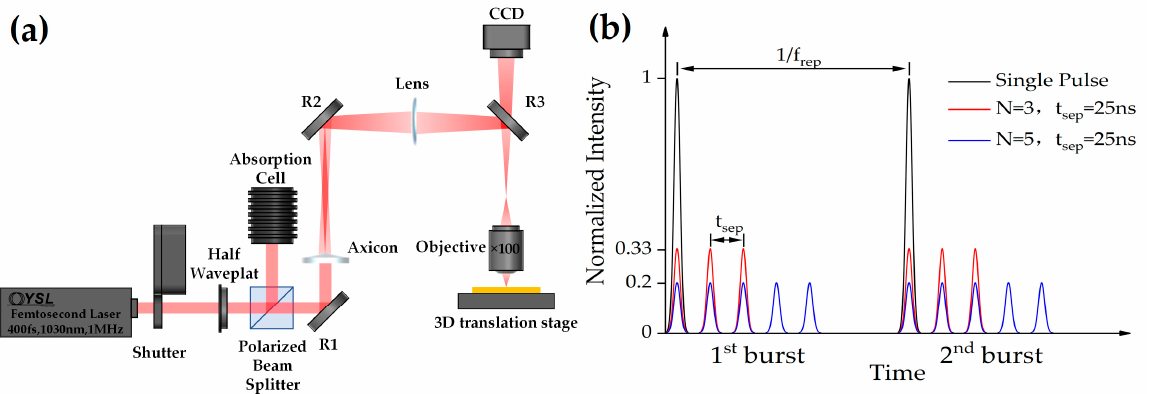
Figure 1. ( a ) Schematic diagram of femtosecond laser processing system. ( b ) A single laser pulse and two burst modes consisting of N = 3 and 5 pulses with tsep = 25 ns and the same total fluence; the frep represents the repetition of 0.1 MHz.